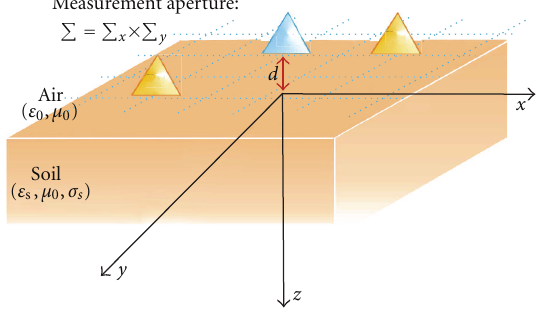
Figure 1: Geometry of the